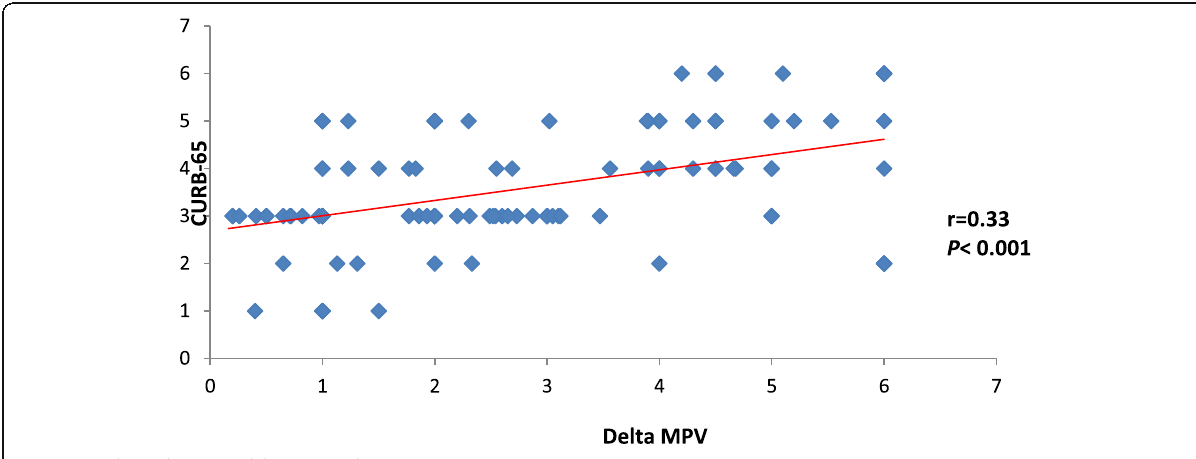
Fig. 3 Correlation between delta MPV and